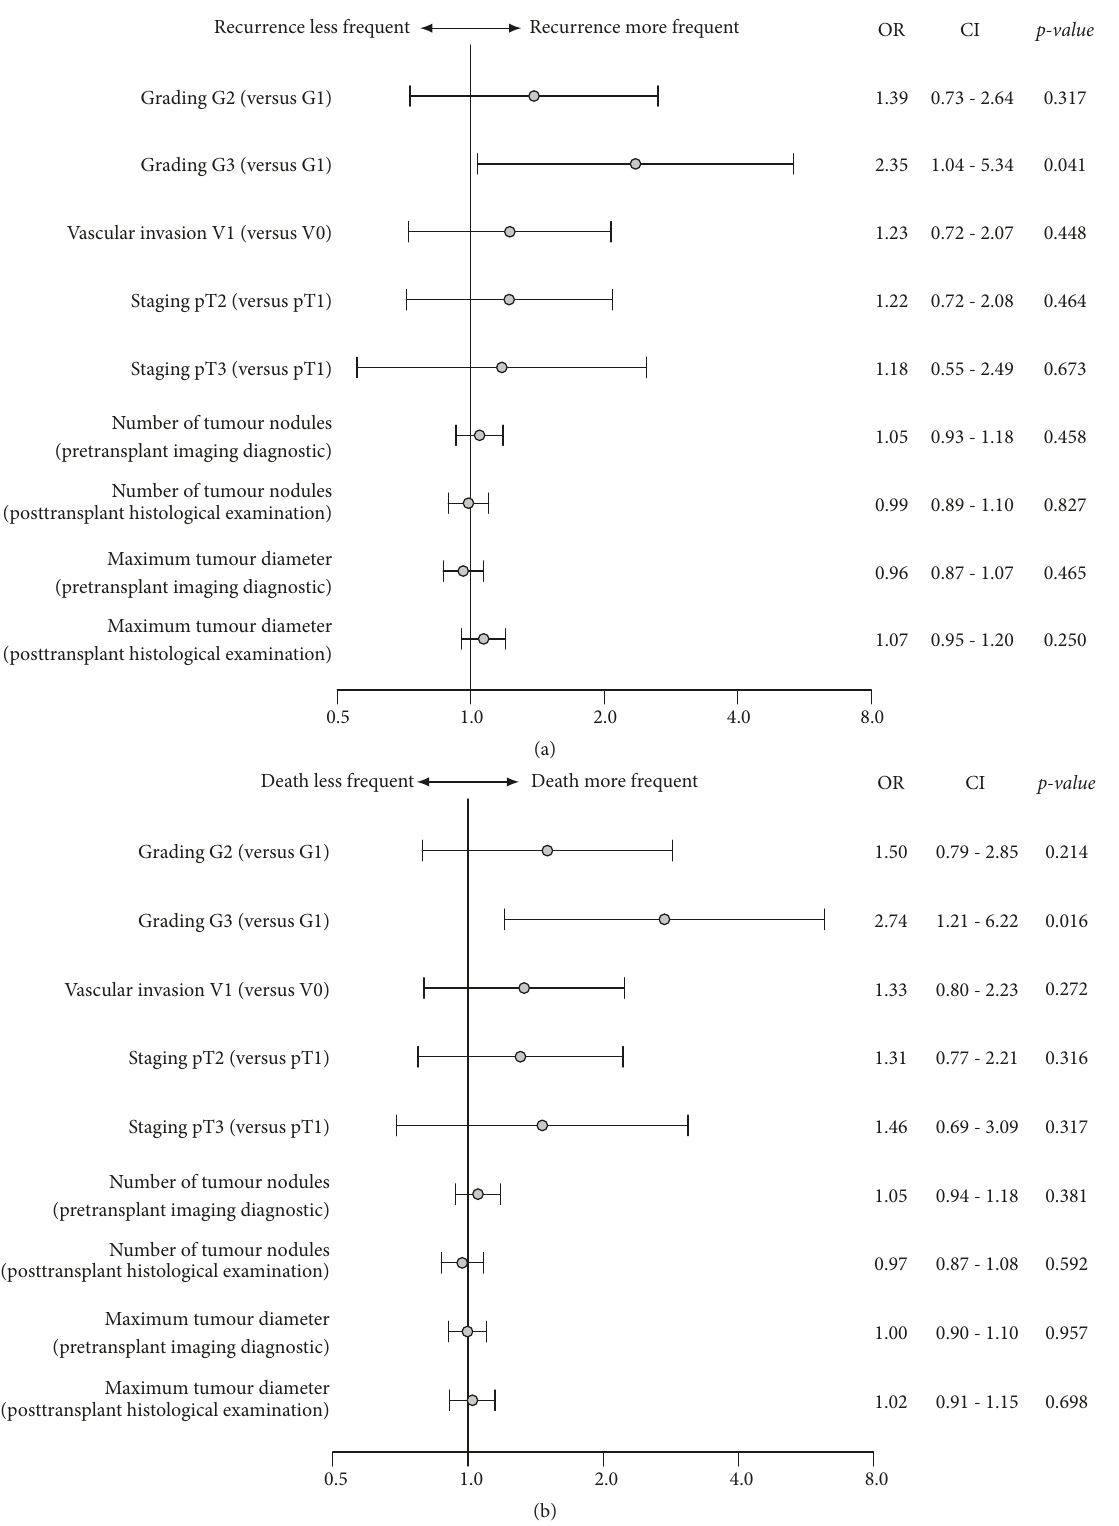
Figure 3: Multivariate Cox regression analysis of recurrence-free patient survival (a) and overall patient survival (b). Multivariate Cox regression analysis regarding overall patient survival and recurrence-free patient survival showed no significant influence of regarding primary tumor stage (pT), microvascular invasion, (V) and number of tumor nodules or maximum tumor diameter pretransplant as well as posttransplant. However, there was a significant elevated risk of patients death and tumor recurrence in patients with undifferentiated tumor grading (hazard ratio 2.353 G3 stage versus G1 stage; P=0.041 for patient survival and hazard ratio 2.739 G3 stage versus G1 stage; P=0.016 for recurrence-free